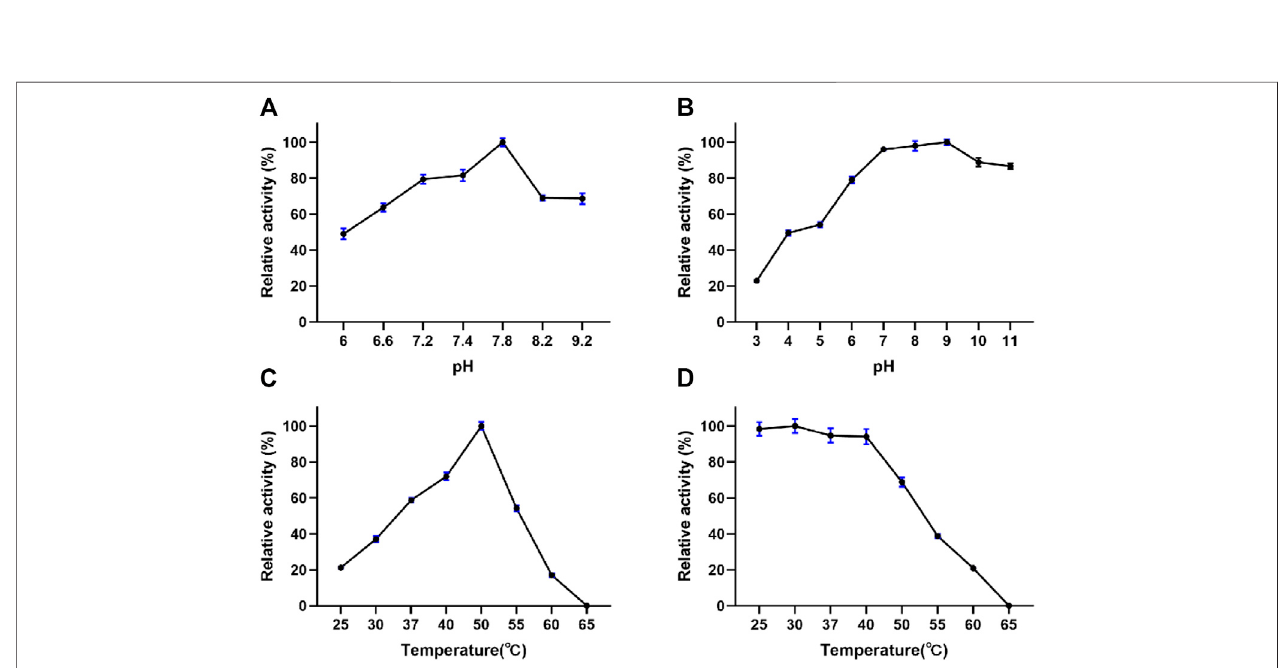
FIGURE4| EffectsofpHandtemperatureonthe fi brinolyticactivityofEPF3( n (cid:1) 3). (A) pHoptimumwasdeterminedinthepHrangeof6.0 – 9.2. (B) pHstabilitywas assessed by measuring the residual activity after incubating EPF3 with buffers of different pH ranges of 3.0 – 11.0 at 4 ° C for 24 h. (C) Temperature optimum was determined by measuring fi brinolytic activity at a temperature range of 25 – 65 ° C. (D) Thermal stability was assessed by measuring the residual activity after incubating EPF3 at different temperatures ’ range of 25 – 65 ° C for 1 h.